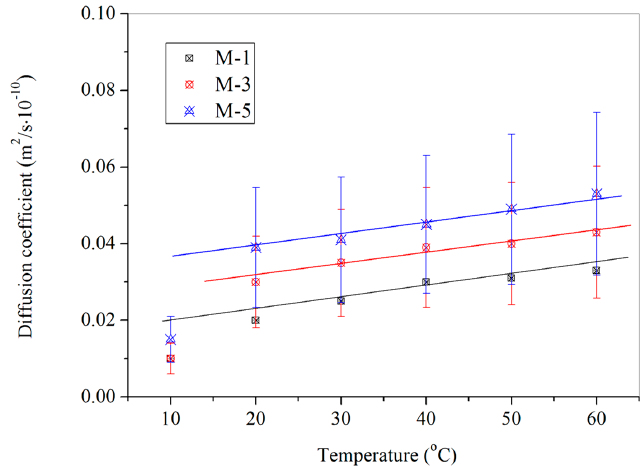
Figure 10. Diffusion coefficient values of microcapsules (content of 2%) in bitumen with different shell thickness values (samples of M-1, M-3 and M-5) under a temperature range of 10 °C–60 °C.